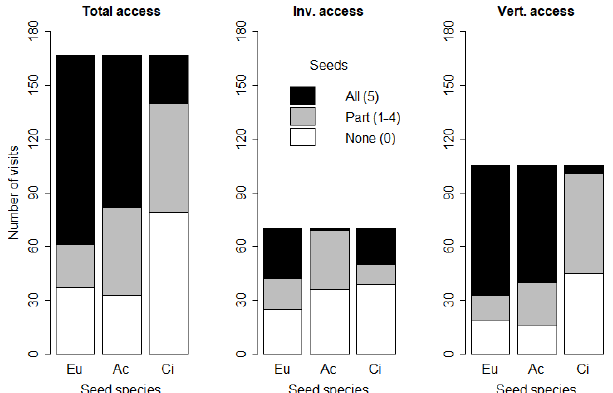
Figure 6. Number of animal visits (any seed used on a given day: missing, eaten, elaiosome detached) where no (0), some (1–4) or all (5) seeds were missing or eaten, according to the feeder type and seed species. Eu: Eucalyptus globulus ; Ac: Acacia dealbata ; Ci: Cistus salviifolius